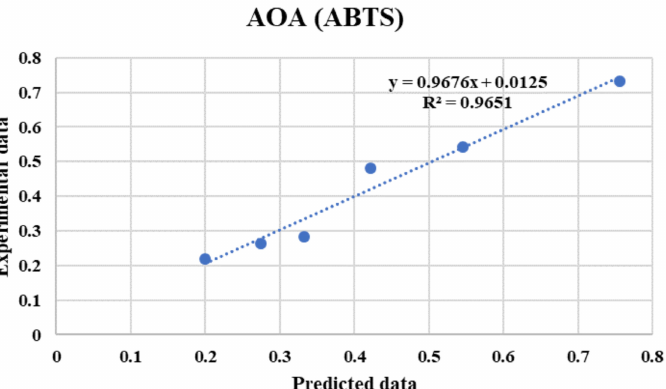
Figure 7. Predicted AOA (ABTS) values of strawberries using artificial neural networks versus experimental values for the testing